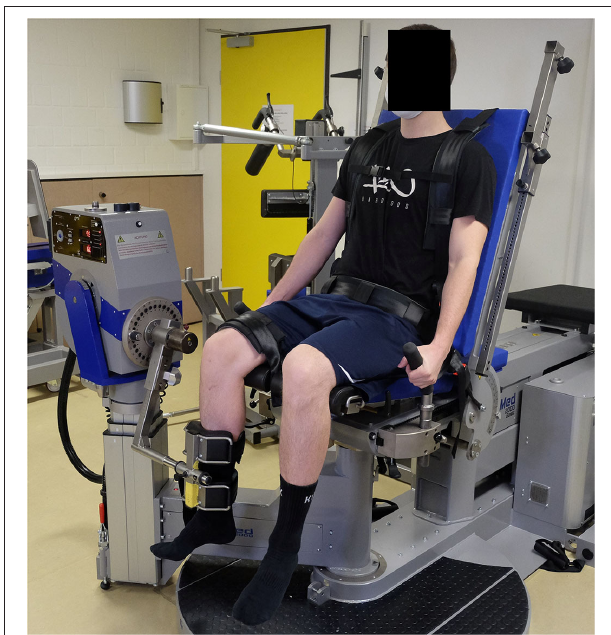
FIGURE 4 | Set-up of the IsoMed 2000 dynamometer and participant positioning for the knee strength